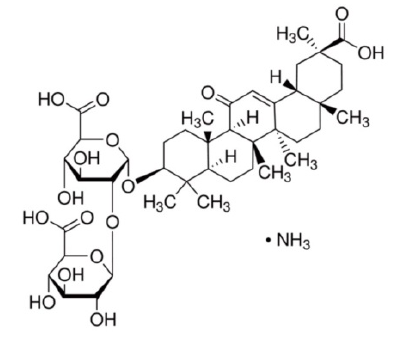
Figure 8. Chemical structure of GRZ (a salt form, monoammonium